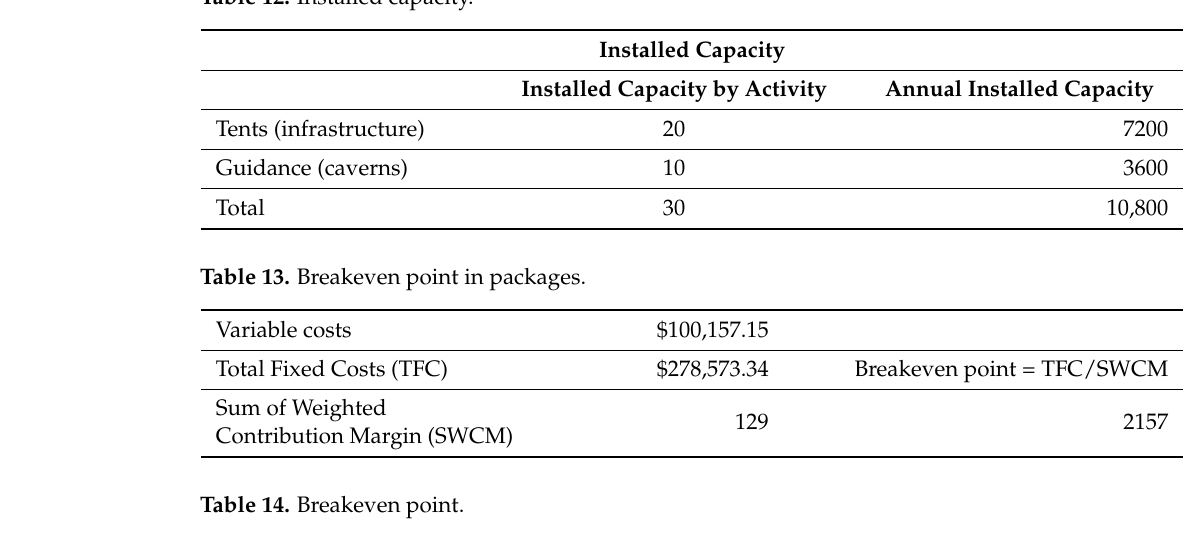
Table 12. Installed capacity.